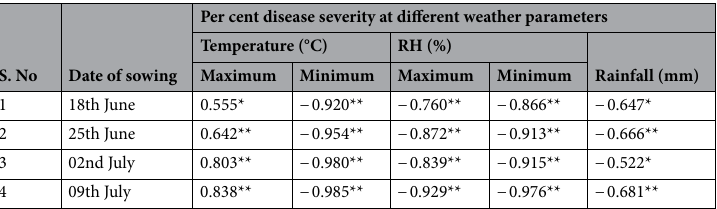
Table 1. Correlation matrix between weather parameters and per cent disease severity in different date of sowing during Kharif, 2018. *and **Represent significant at 5 and 1%, respectively.